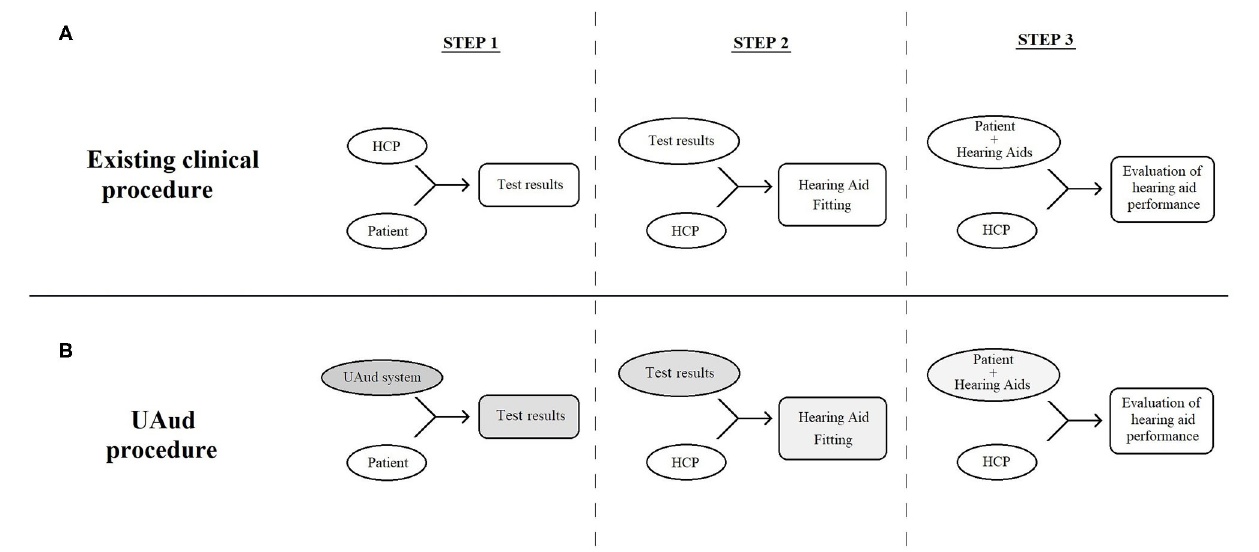
FIGURE 1 | Schematic representation of the 3-step existing (A) and user-operated audiometry (B) procedure, consisting of three parties, i.e., the patient, the user-operated system and the HCP. The user-operated examination affects step 1, and consequently steps 2 and 3, as medical decisions are based on the results of the